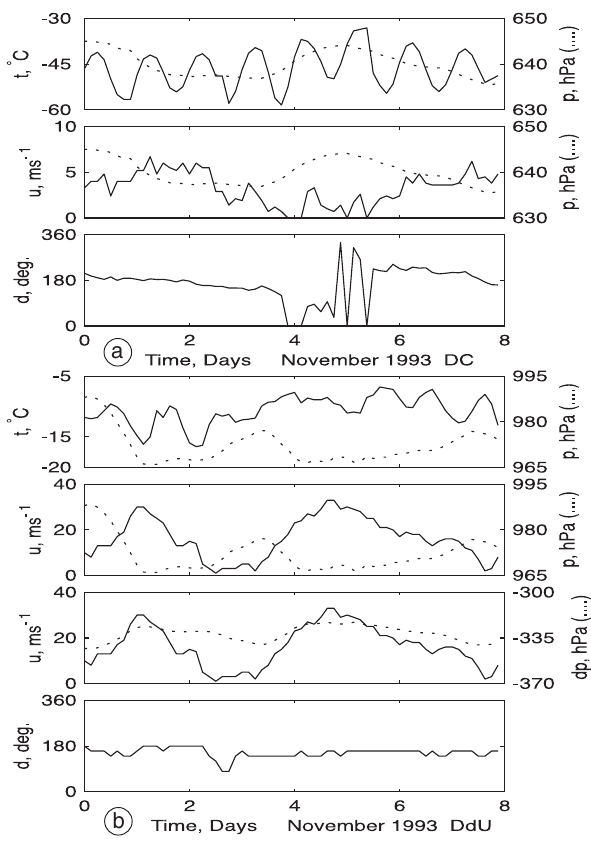
Fig. 4a,b. Time series of meteorological parameters: a) for Dome C; b) for Dumont d’Urville depicting strong wind events around 1 November and from 4 to 7 November 1993,